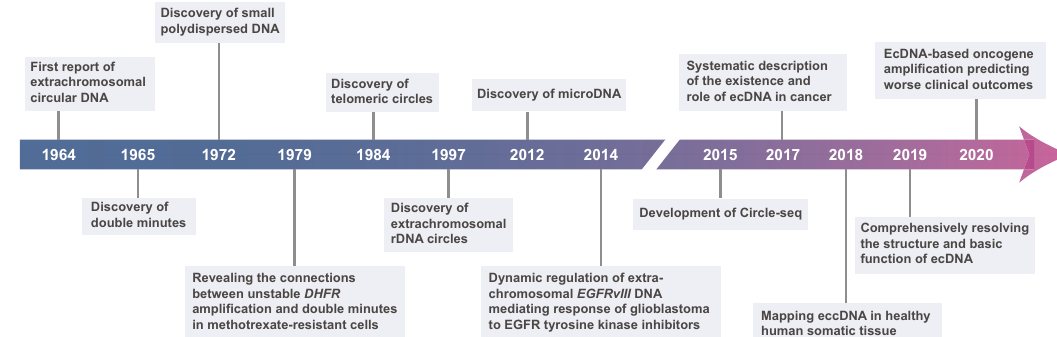
Fig. 1 Timeline of the milestone discoveries and research advances of eccDNA. After the fi rst discovery of eccDNA in 1964, multiple categories of eccDNA in various species have been identi fi ed. With the development of high-throughput sequencing technologies, the biological properties and functions of eccDNA have been deeply